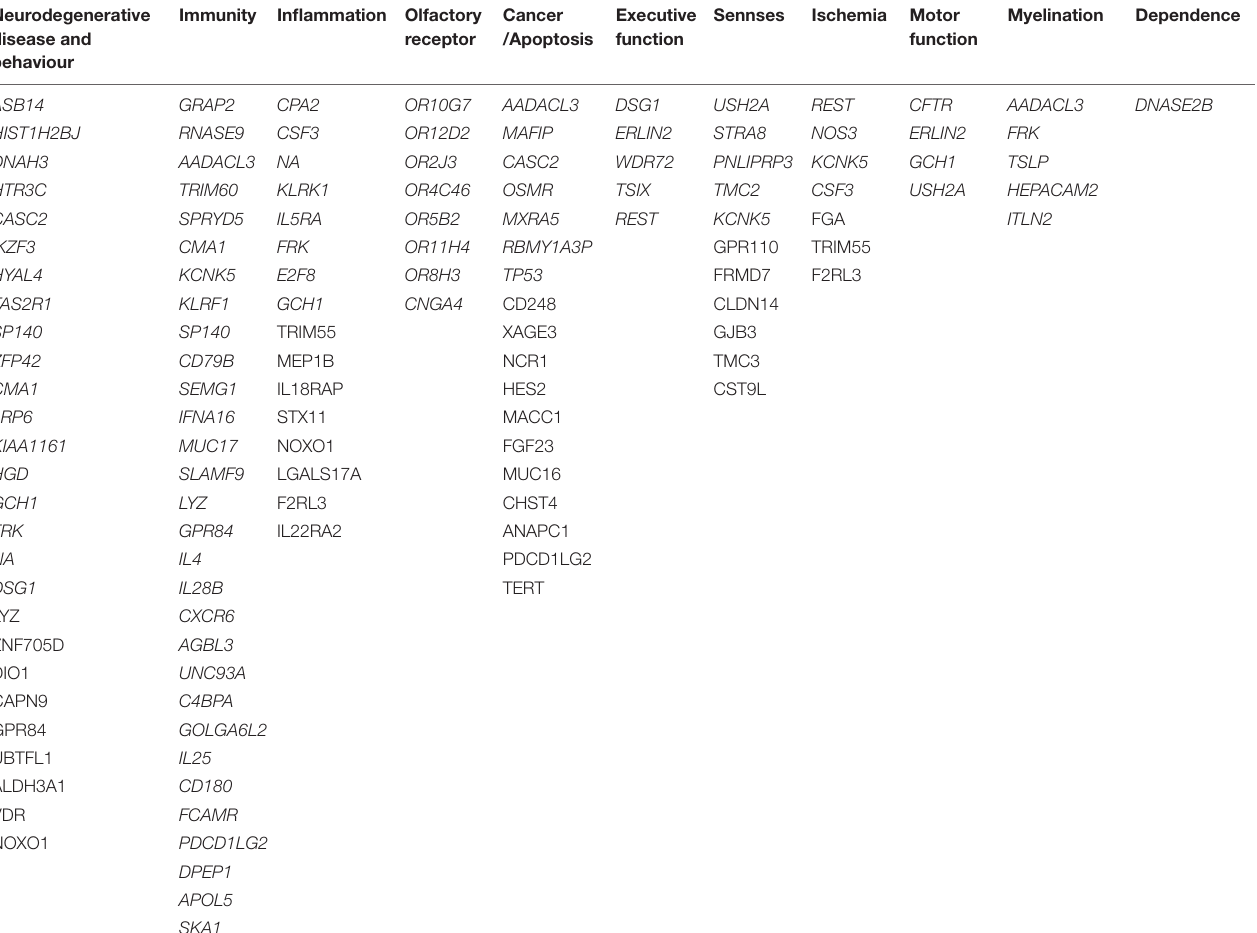
TABLE 2 | Genes co-expressed with ACE2/TMPRSS2, clustered by groups. Neurodegenerative disease and